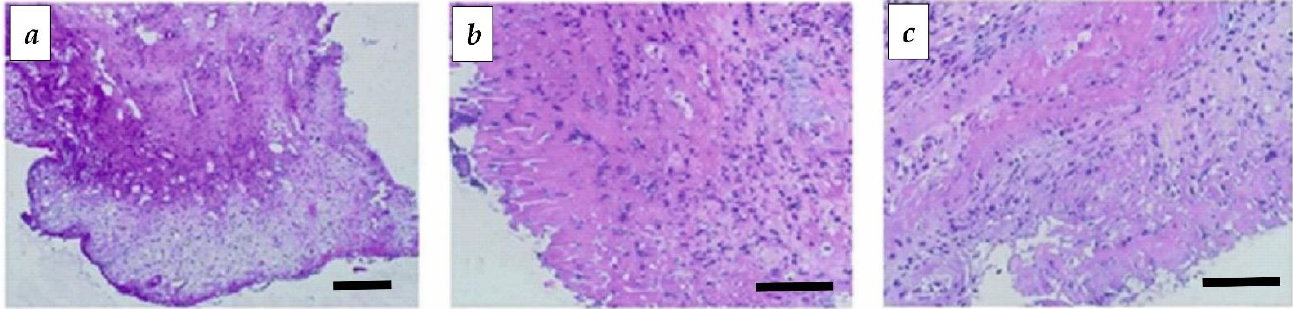
Figure 8. Histology of the edge of the decubital ulcer in the patient of the control group on the 1st ( a ), 14th ( b ), and 28th ( c ) day of treatment. The scale bar is 100